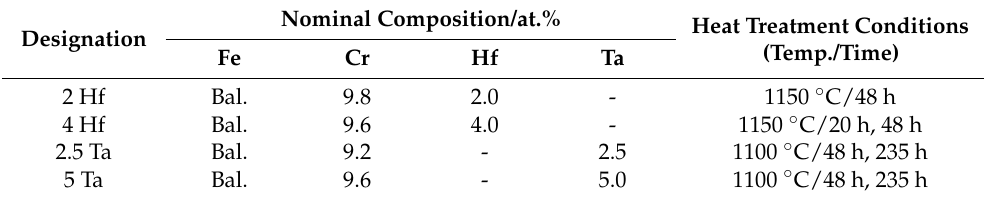
Table 1. The nominal compositions of the alloys studied (compositions are given in atomic